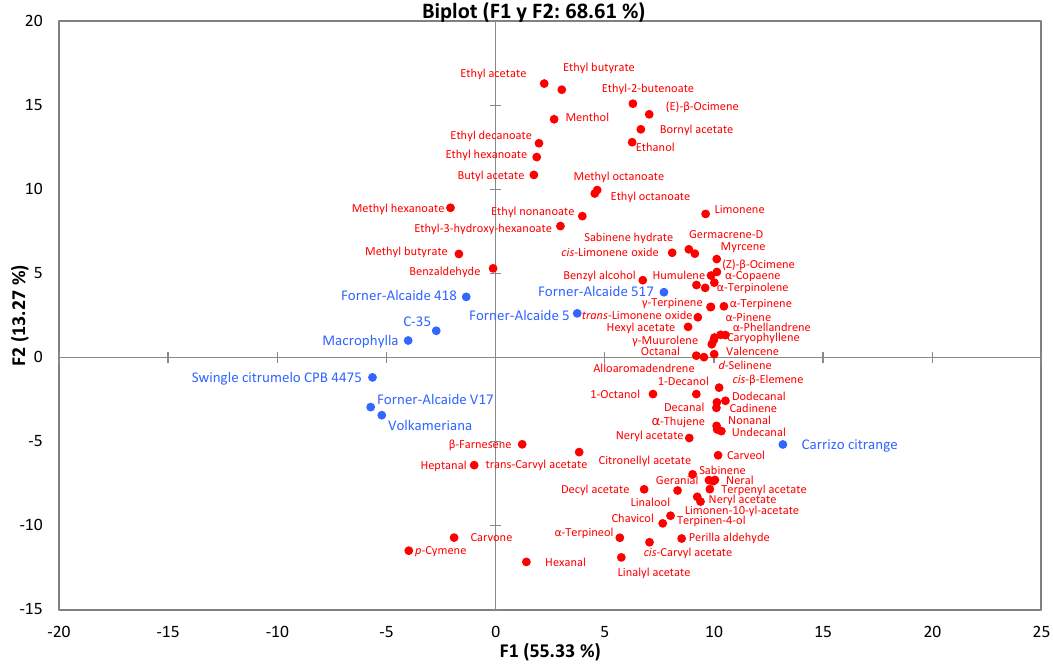
Figure 2. A principal component analysis (PCA) plot showing the relationships among volatile compounds and the factor rootstock.